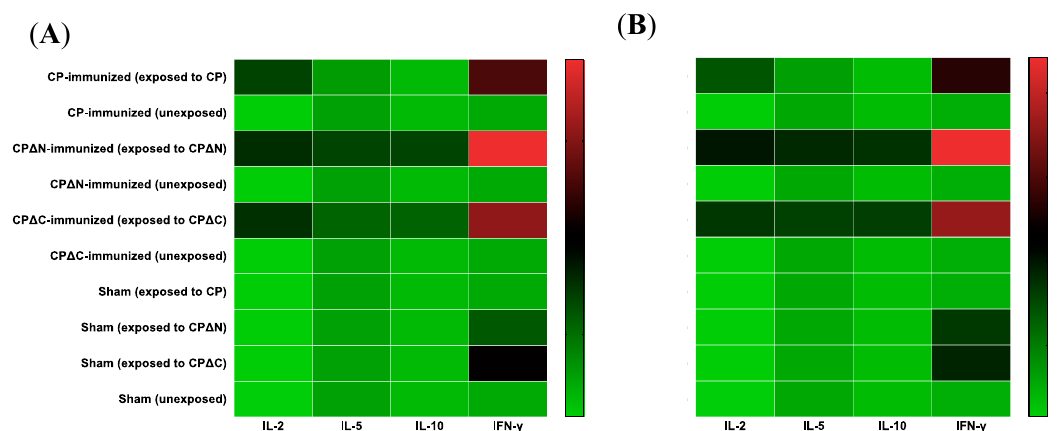
Figure 4. Heatmap of T-cell-mediated immune response to the corresponding MAstV CPs. The MAstV vaccine candidates (5 µg/mouse) combined with an equal volume of AbISCO-100 adjuvant (10 µg/mouse) were injected into NMRI mice ( n = 8 per group, 4 weeks old) twice with a three-week interval. Three weeks after the second immunization, mice splenocytes were harvested from each group of mice: CP-immunized mice, CP ∆ N-immunized mice, and CP ∆ C-immunized mice. Mice injected with pDual-GC-vector-transfected cell lysate combined with adjuvant was also analyzed as a sham ( n = 8). The splenocytes of four mice per group were then extracted, washed, and cultivated ex vivo (2 × 10 5 cells/well) and stimulated by exposing to ( A ) 2 µg/mL and ( B ) 4 µg/mL of the corresponding MAstV CPs as described in Materials and Methods. The culture supernatants from stimulated splenocytes were collected and assessed for secreted cytokines IL-2, IL-5, IL-10, and IFN- γ by using a mouse Th1/Th2 Cytokine Cytometric 6-plex Array Bead kit (Invitrogen), Luminex ® 100/200™ System and xPONENT ® software (Luminex Corporation, Austin, TX, USA). The splenocytes of the sham group ( n = 8) were also independently exposed to each of the three MAstV CPs. The data are mean COD readings of duplicate experiments, illustrated as log 10 values in the